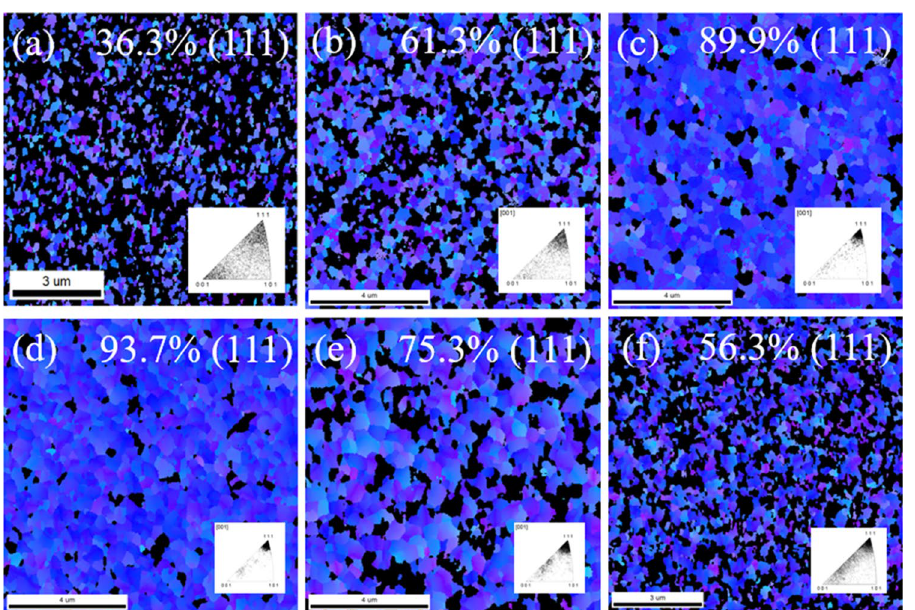
Figure 6. Plane-view EBSD inverse pole figure (IPF) maps of sputtered Cu films deposited with substrate biases of ( a ) 0 V, ( b ) − 50 V, ( c ) − 100 V, ( d ) − 150 V, ( e ) − 200 V and ( f ) − 250 V showing